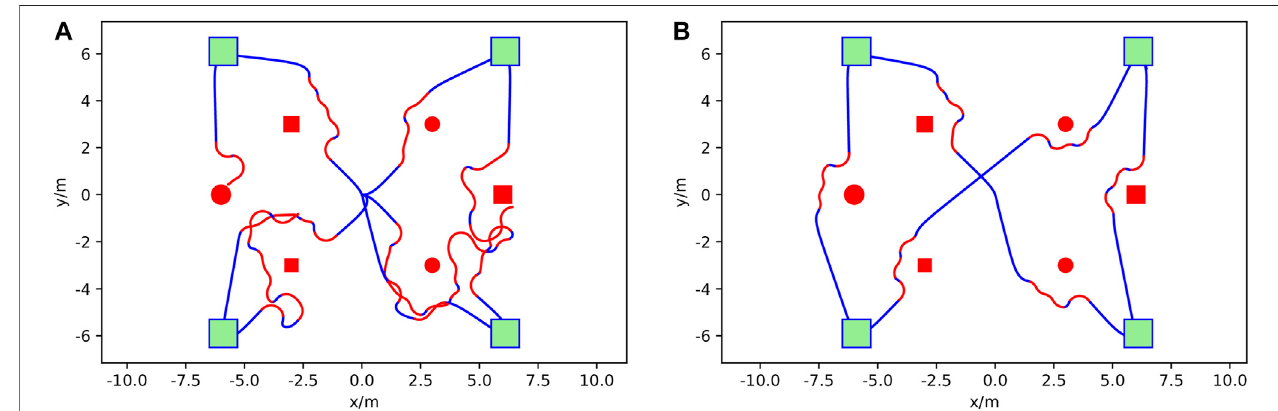
FIGURE 7 | Obstacle avoidance mission comparison at different training episodes in the AGV simulation. (A) is at 50 episodes and (B) is at 350 episodes. Mission waypoints are shown as green squares, obstacles are shown in red, DRL agent augmented paths for avoidance in red, and the vehicle trajectory following the mission path in blue. The AGV starts from the top right waypoint and then goes to the bottom right, top left, bottom left, and top right in sequence.